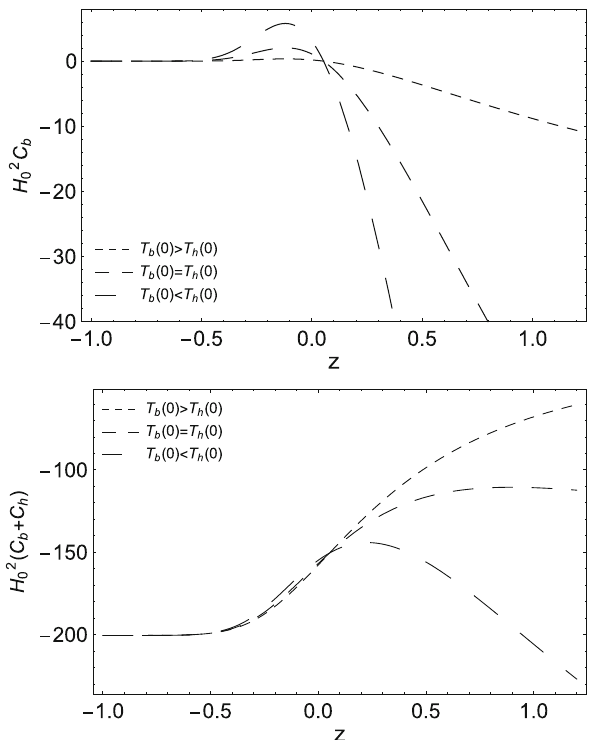
Fig. 3 GB model: in the upper graph we show the evolution of the heat capacity of the bulk. On the other hand, in the lower graph we depict the evolution of the sum of capacities of the bulk and the horizon. Following the criteria 1 and 2 exposed in Sect. 3, we observe that the thermal equilibrium is possible as a transient phenomenon sum of capacities C b + C h is negative. This happens